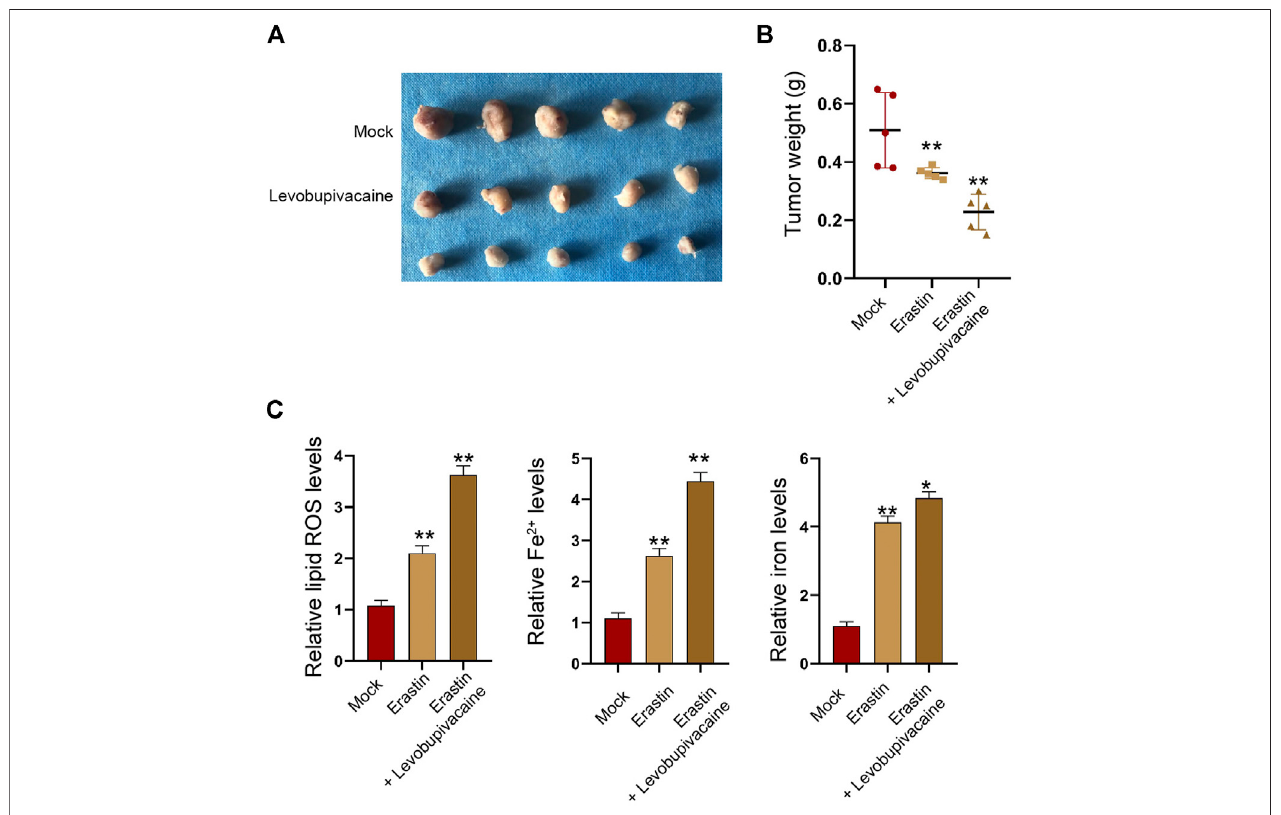
FIGURE9| Levobupivacaineenhancesinhibitoryeffectoferastinongastriccancercellgrowth invivo .ThemicewereinjectedwithSGC7901cellsandtreatedwith erastin(15 mg/kg)andlevobupivacaine (40 μ mol/kg). The tumor tissues (A) andtumor weight (B) wereshown. (C) Thelipid ROS,Fe 2+ ,iron levels wereanalyzed. N (cid:2) 5, mean ± SD, ** p <